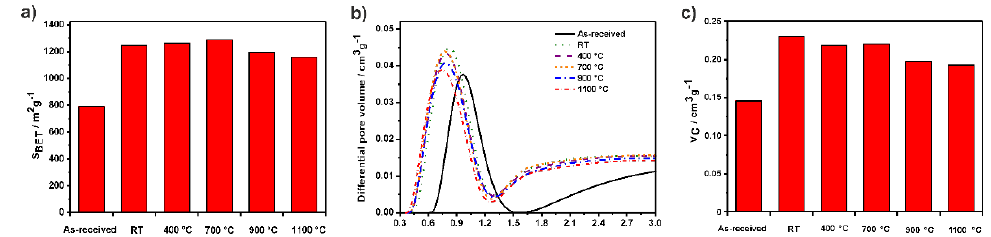
Figure 1. ( a ) Histogram representing the apparent specific surface area (S BET ), ( b ) nonlocal density functional theory (NLDFT)pore size distribution, and ( c ) histogram of cumulative volume (V C ) for as − received, purified (RT) and annealed SWCNTs (at 400, 700, 900, and 1100 °C).